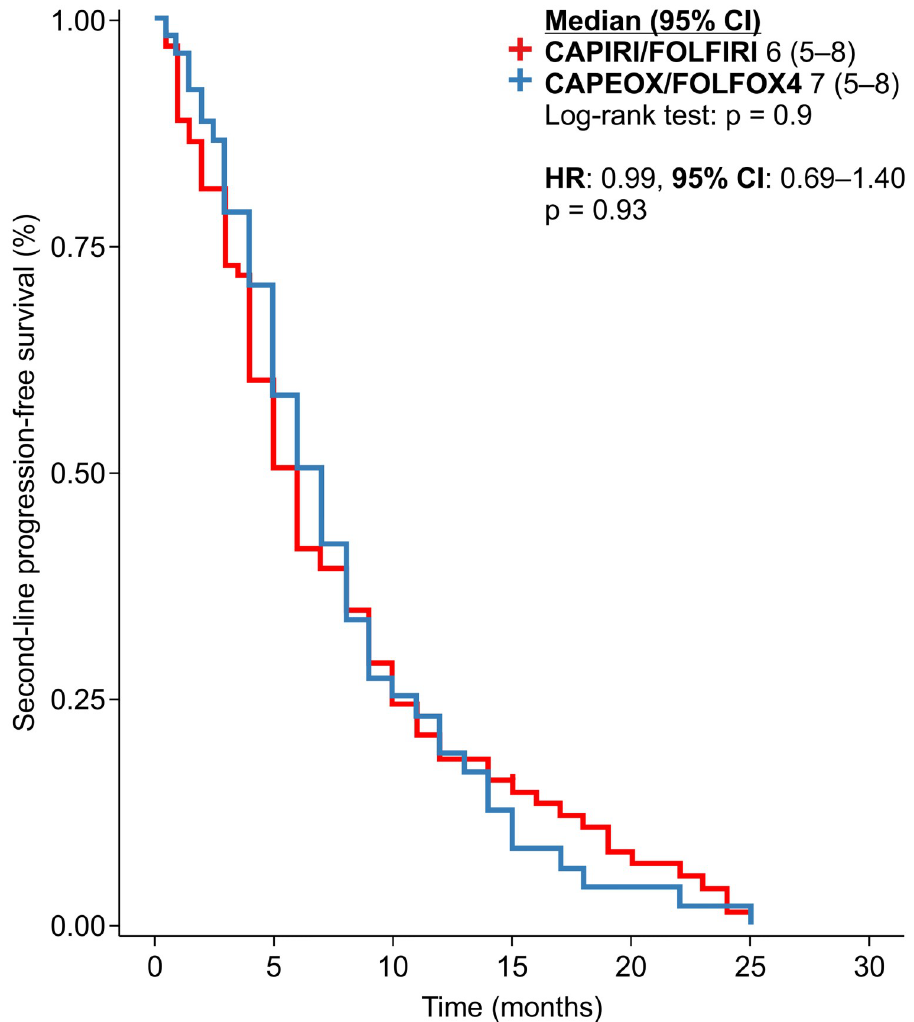
Fig 5. Progression-free survival in the second-line treatment setting in line with the backbone chemotherapy, irrespective of bevacizumab dose.